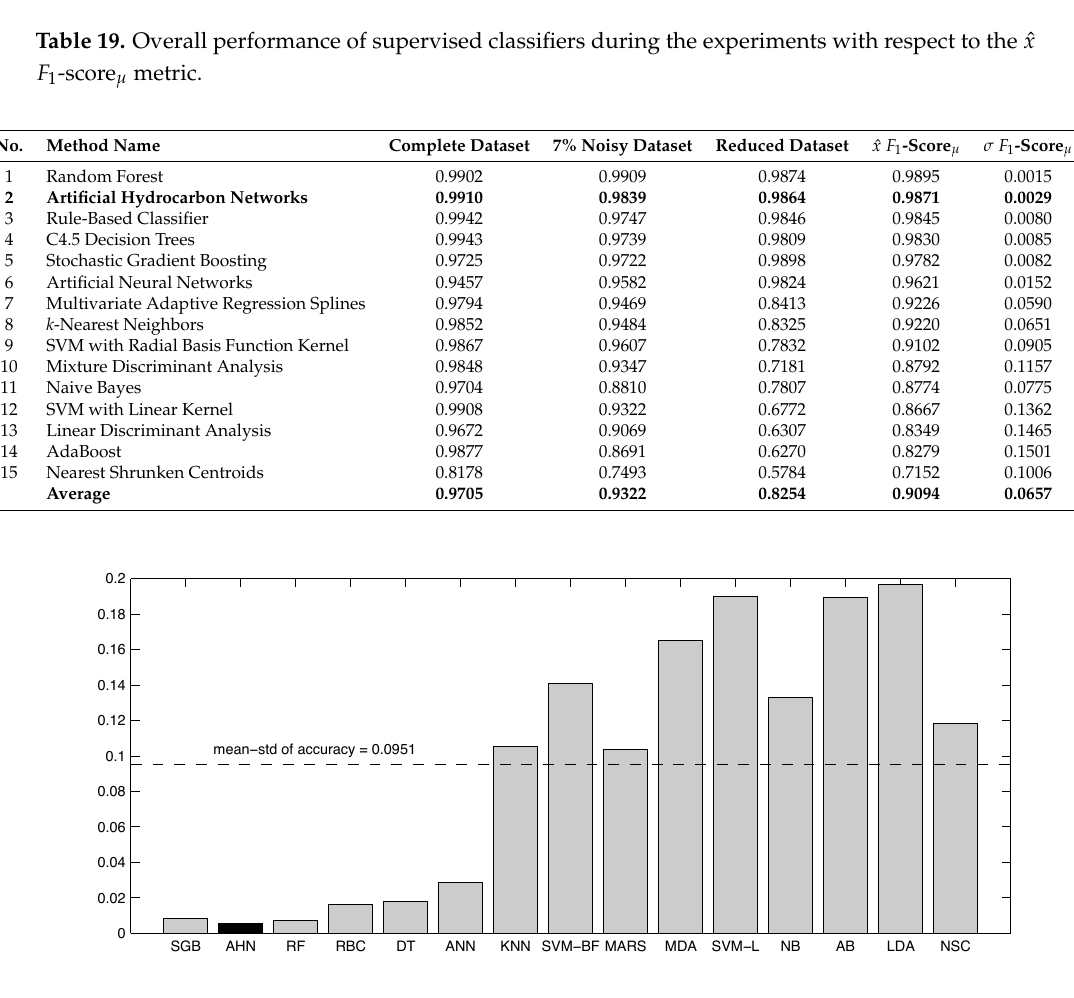
Figure 7. Overall variability of supervised classifiers present in the experiments with respect to the accuracy